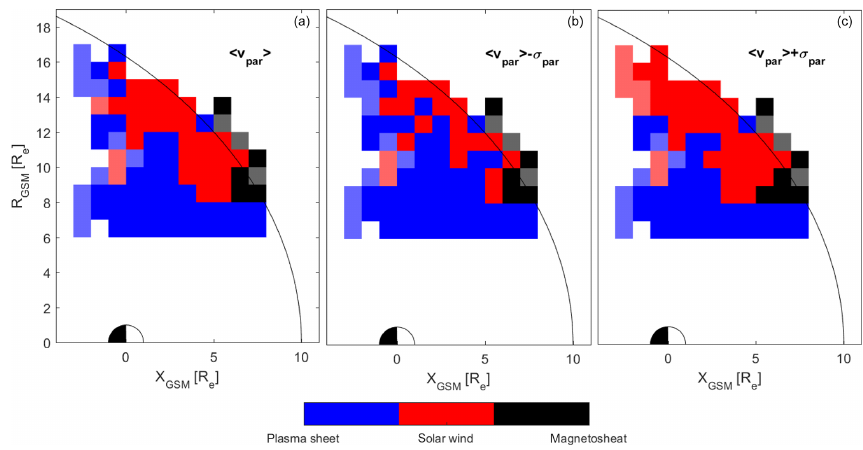
Figure 9. The figure depicts the results of tracing for each starting bin. The different panels show various starting parallel velocities. Cases for the starting parallel velocities from (a) to (c) are average parallel velocity, lower standard deviation parallel velocity and upper standard deviation parallel velocity. Transparent colors represent the bins with less than 30min of EDI